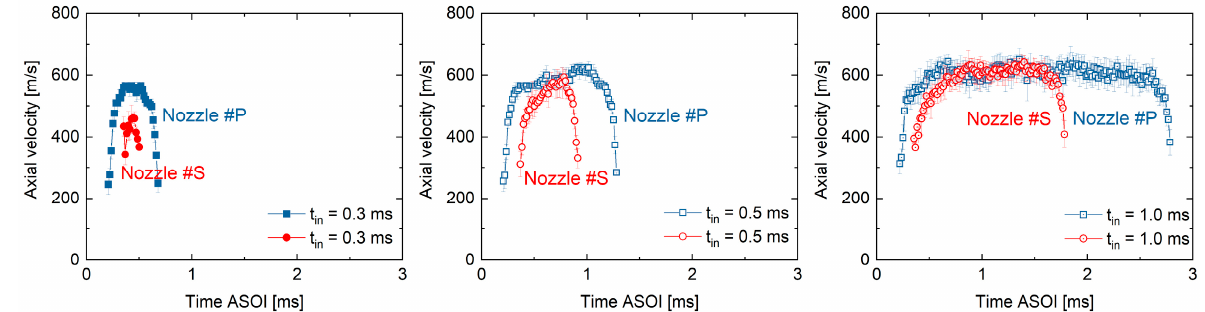
Figure 4. Time sequence results of spray axial velocities at the nozzle exit.